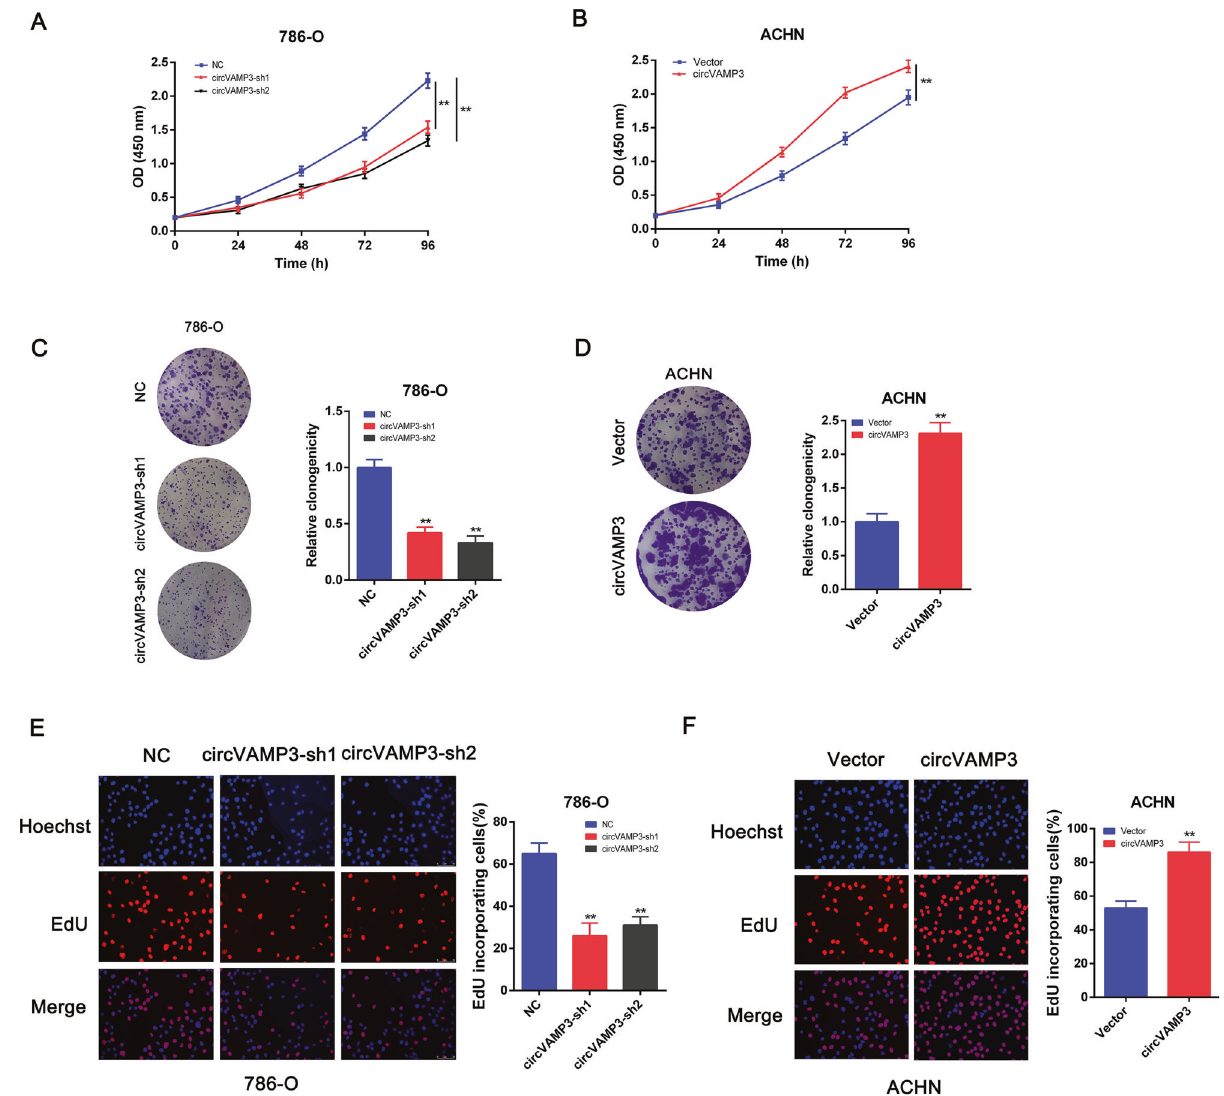
Fig. 4 CircVAMP3 promotes proliferation in RCC cells. A CCK-8 assay was performed to analyze cell viability in 786-O cells with circVAMP3 knockdown. B CCK-8 assay was performed to analyze cellular viability after circVAMP3 overexpression. C Micrographs (left panel) and relative quanti fi cation (right panel) of colony-formation assay after circVAMP3 knockdown. D Micrographs (left panel) and relative quanti fi cation (right panel) of colony-formation assay after circVAMP3 overexpression. E Micrographs (left panel) and quanti fi cation (right panel) of EdU- incorporated cells in 786-O cells with circVAMP3 knockdown. F Micrographs (left panel) and quanti fi cation (right panel) of EdU-incorporated cells after circVAMP3 overexpression. The results are presented as the mean ± SD. * P < 0.05; ** P <